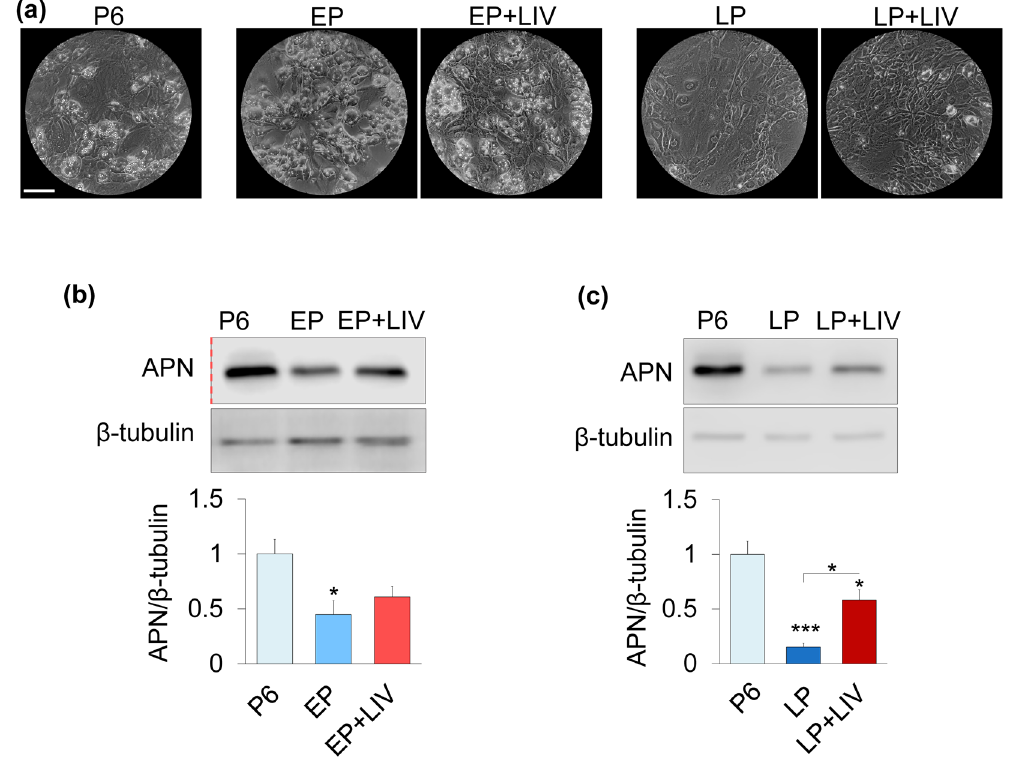
(p < 0.05) and 39.1% (NS) in the EP and EP + LIV groups, respectively. ( c ) The P6 group showed robust APN protein levels after three days, APN levels in LP was 85% lower when compared to P6 (p < 0.001). The LP + LIV group showed a 366% increased APN levels compared to the LP group (p < 0.05) while still remaining 42% lower than P6 control (p < 0.05). Experiments in ( b , c ) were performed and analyzed independently. Scale bar: 200 µ m. n = 3/grp. Group comparisons were made using one-way ANOVA followed by a Newman-Keuls post- hoc test. p < 0.05, ** p < 0.01, *** p < 0.001, against control and each other. Red dashed line in 5b indicates a cropped blot. Full-length blots are presented in Supplementary